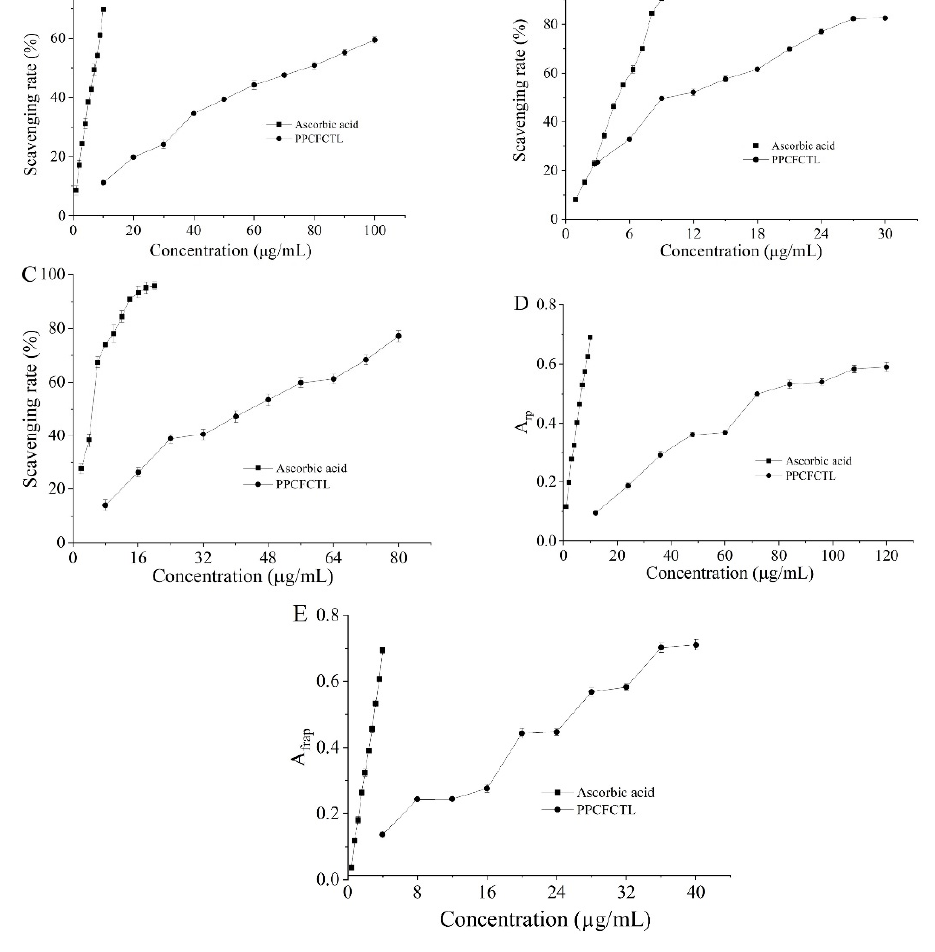
Figure 1. Antioxidant activities of PPCFCTL: ( A ) DPPH radical scavenging activities, ( B ) ABTS + radical scavenging activities, ( C ) superoxide anion radical scavenging activities, ( D ) reducing power activities, ( E ) ferric reducing antioxidant power activities. Data represent means of three independent experiments (mean ± SD).